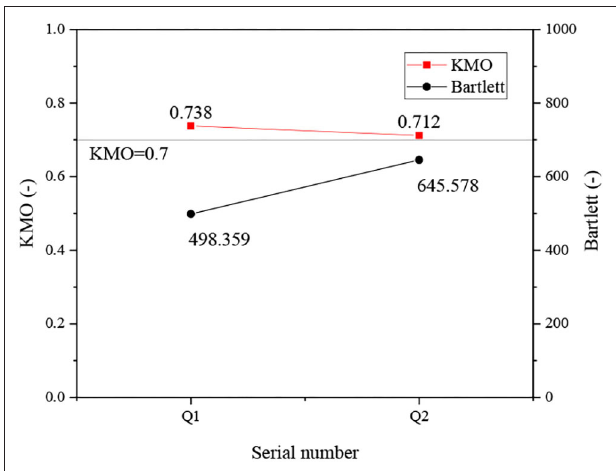
FIGURE 3 | Validity analysis of the questionnaire surveys (QS)